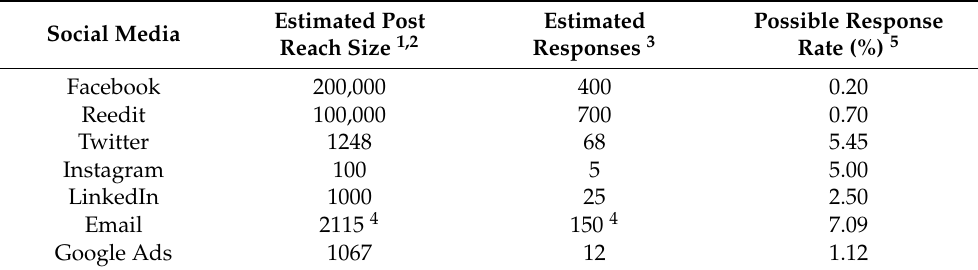
Table 1. Estimations of the response rate directly generated by the Survey questionnaire link over social